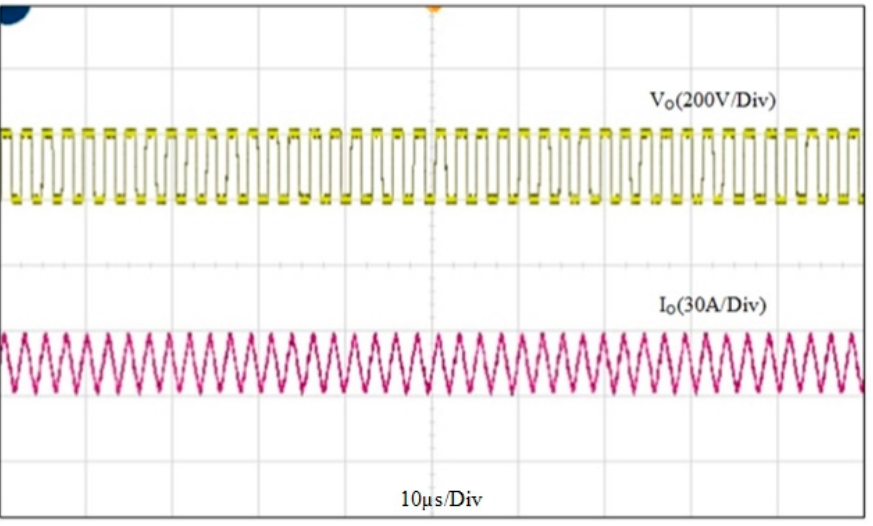
Figure 19. Output waveforms for non-ferrous heating mode during experiment.